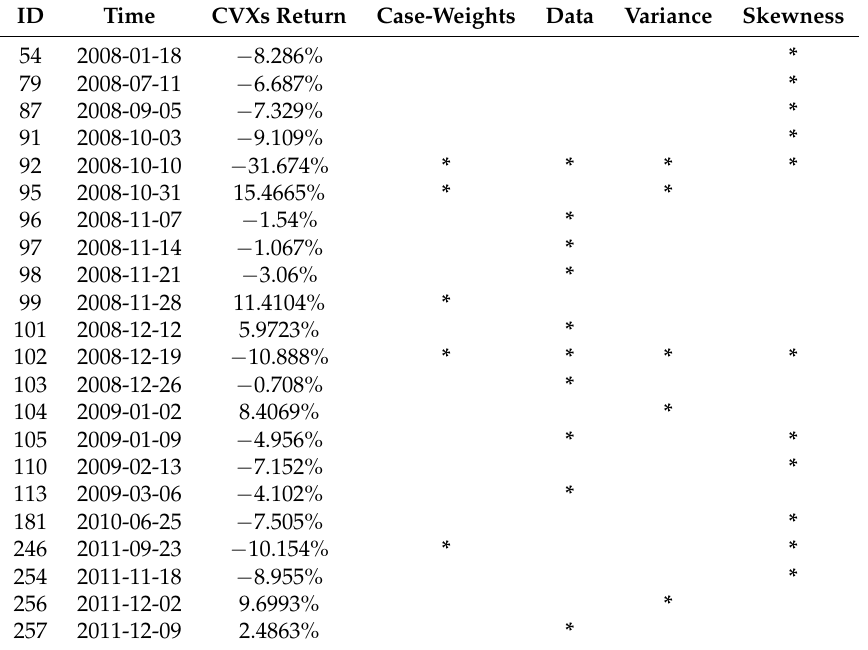
Table 3. Summary of the curvature-based diagnostic